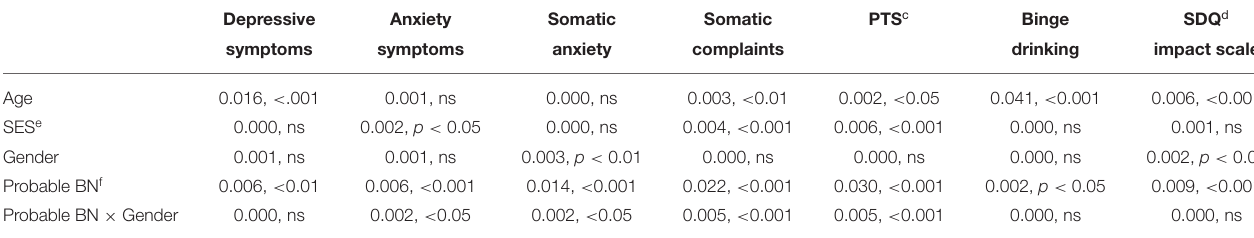
TABLE 3 | Effect sizes for each dependent variable (problems scores) ( η 2 , p ) a,b